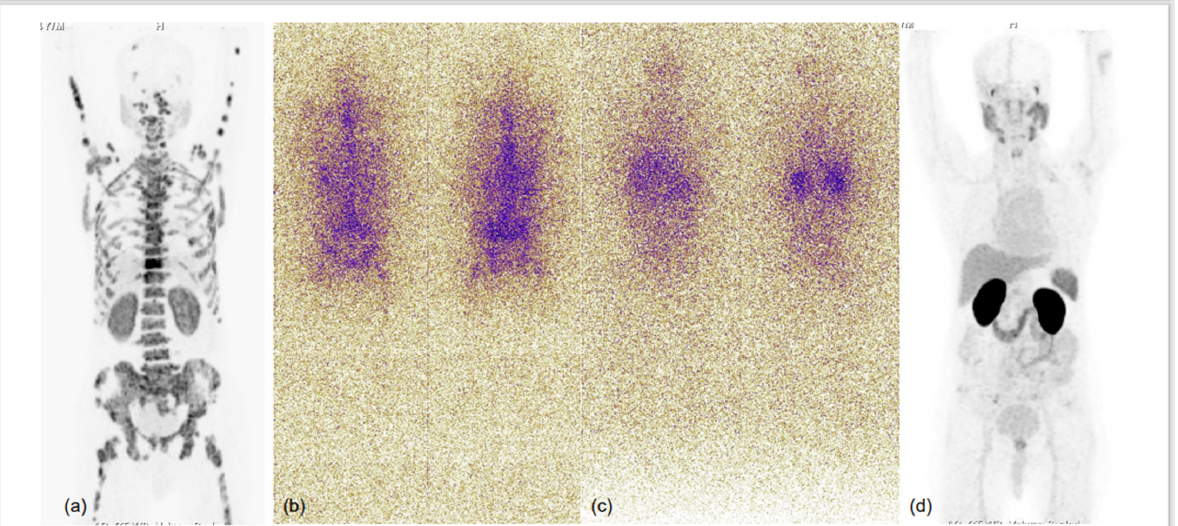
Figure 4. 75-year-old male with known case of coronary artery disease, post-CABG and on cardiac remodeling agents, presented with multiple sites of skeletal pain, weakness and high serum PSA >500.0 ng/mL. Needle biopsy from prostate demonstrated acinar adenocarcinoma (Gleason score 4 + 3 = 7), underwent bilateral orchidectomy. 68 Ga-PSMA-11 PET-CT performed for high-serum PSA showed low-grade PSMA expression in relatively smaller prostate gland, with no significant PSMA-expressing or otherwise pelvic and retroperitoneal lymph nodes and PSMA-expressing sclerotic and marrow metastatic lesions involving entire visualised skeleton. In view of cardiac co-morbidity and post-CABG status, chemotherapy and anti-androgen therapies were not considered, and he was taken for 225 Ac-PSMA-617 (alpha radionuclide) therapy. MIP images of 68 Ga-PSMA-11 PET-CT scans at baseline ( a ) and 3 months after second cycle of 225 Ac-PSMA-617 ( d ), and first ( b ) and second ( c ) post alpha therapy planar gamma scans showed excellent scan response; PSA decreased to 0.405 ng/mL and patient became asymptomatic.